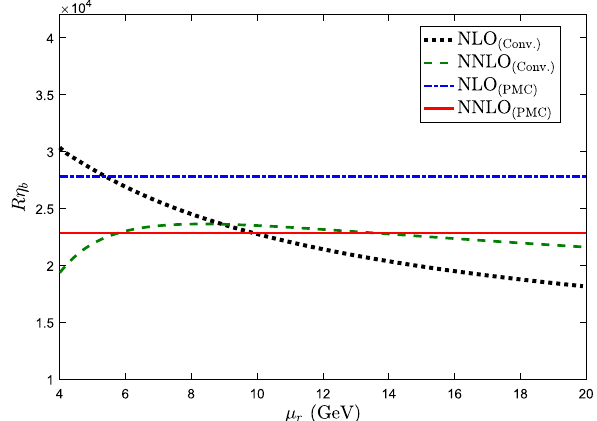
Fig. 2 The R η -ratio as a function of μ r under conventional and PMC b scale-setting approaches. The dotted and the dashed lines are for con- ventional scale-setting up to NLO and NNLO levels, respectively. The dash-dot and the solid lines are for the PMC scale-setting up to NLO and NNLO levels, respectively